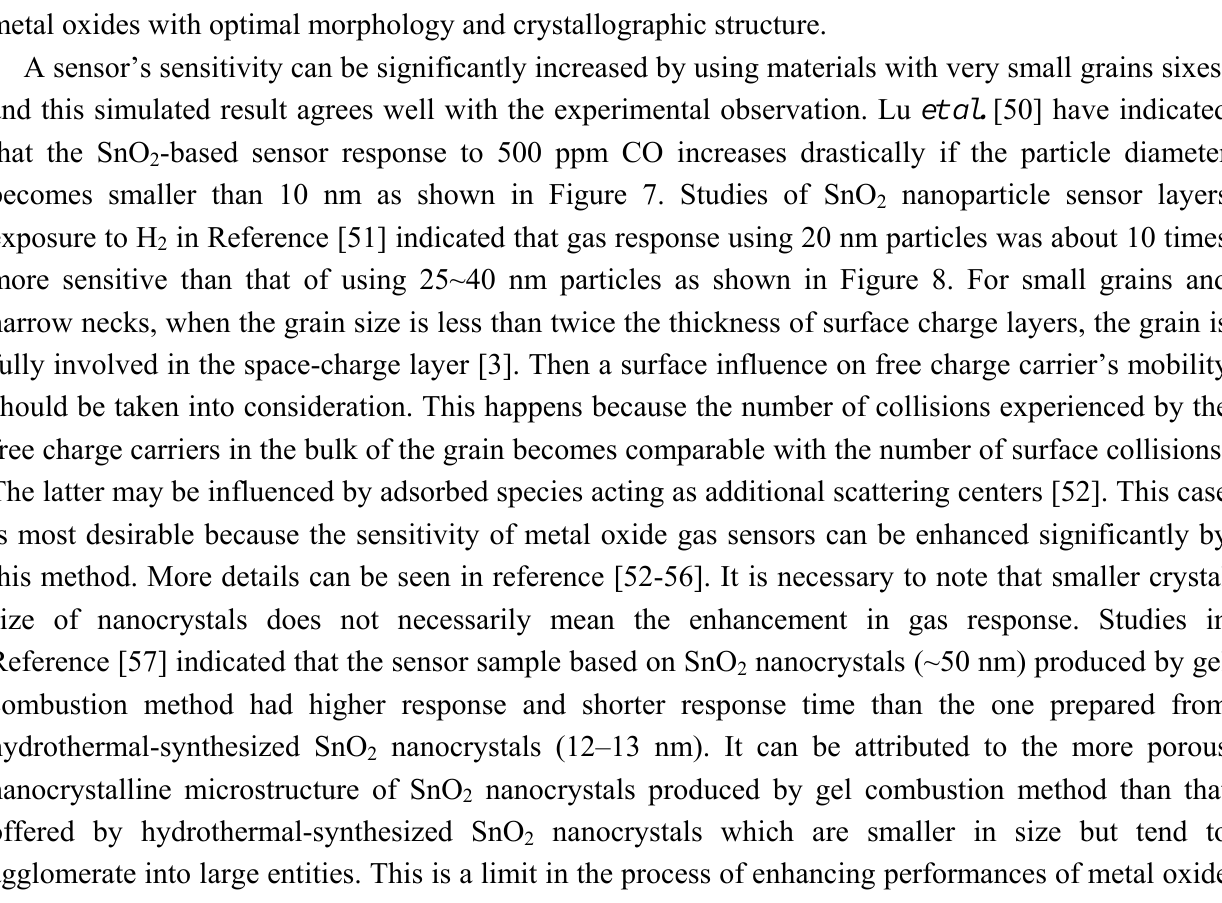
2 . (b) Band diagram of the pristine SnO 2 2